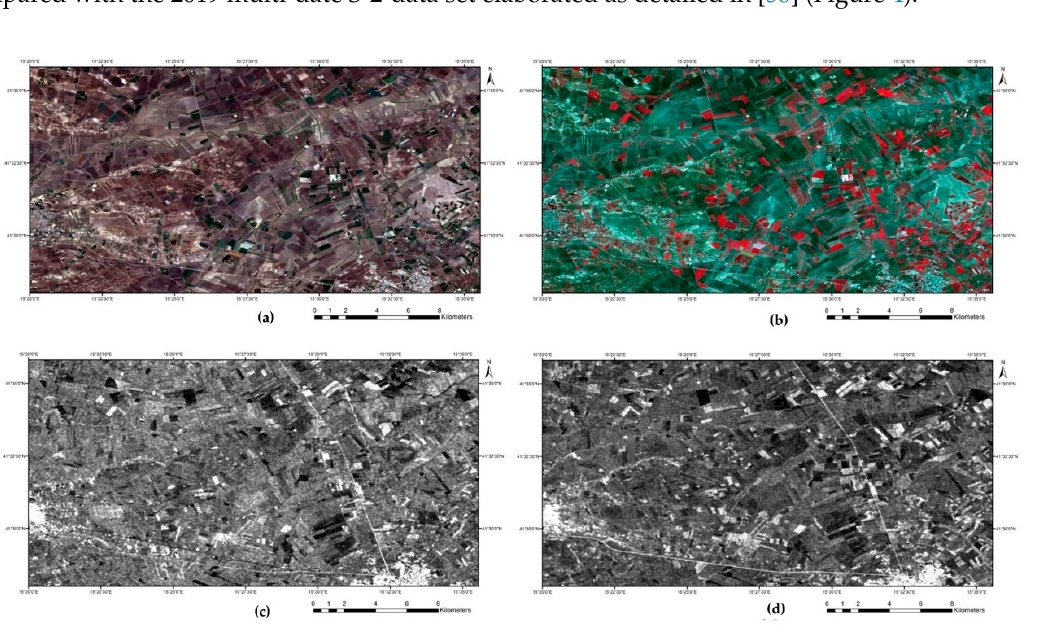
Figure 4. Study area by S-2 and S-1 satellite imagery: ( a ) S-2 image captured on 20 October, 2019 (natural colors RGB 4,3,2); ( b ) S-2 image captured on 20 October, 2019 (natural colors FCIR 8,4,3); ( c ) S-1 VV polarization captured on the 19th and ( d ) VH polarization captured on 19 October, 2019.